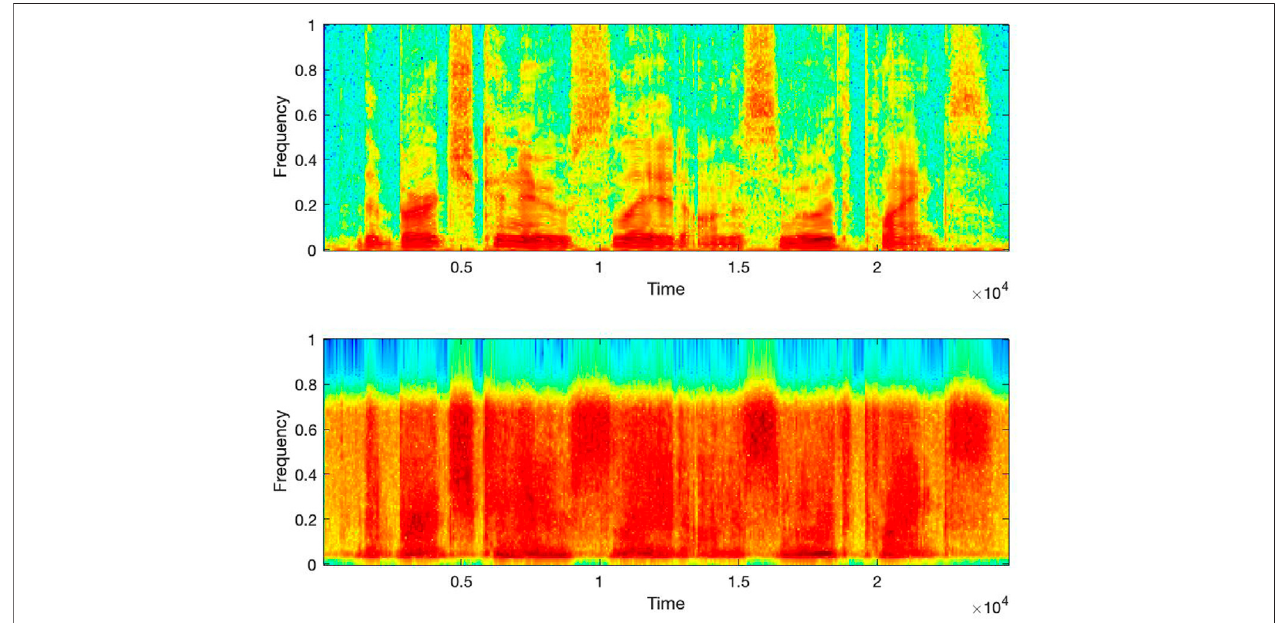
FIGURE 4 | Spectrogram ofthe input fi le from Figure 2 . (A) Spectrogram of the original signal. (B) spectrogram of the signal passed through the simulator. Notice the increased noisy components in the bottom signal.